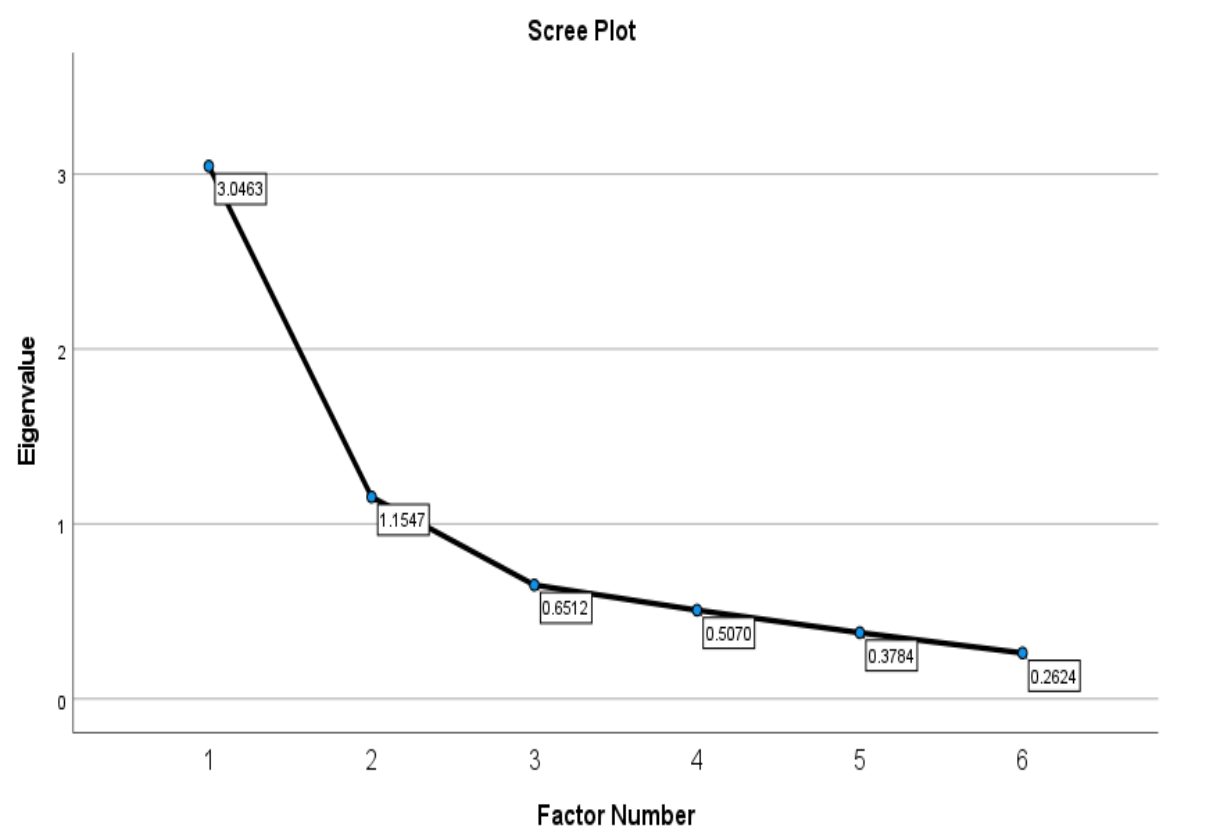
Figure 3. Sedimentation graph: representation of the magnitude of the eigenvalues.